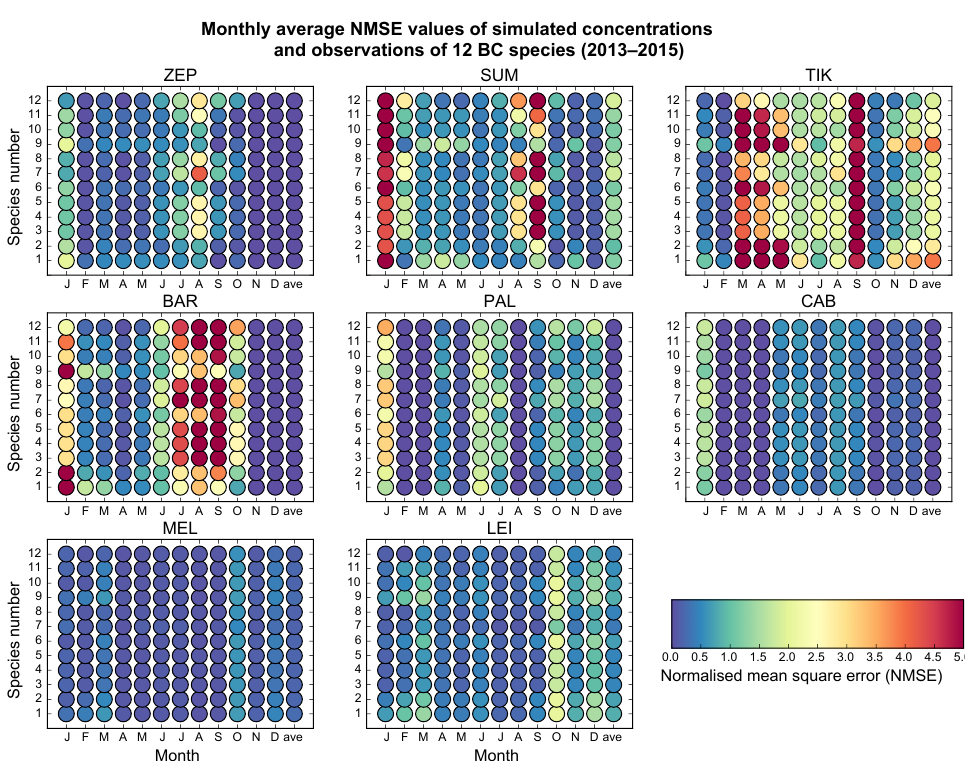
Figure 4. Monthly average NMSE values due to use of 12 different BC species defined in Table 2 for the eight stations with complete data in the period 2013–2015. The annual mean is denoted as